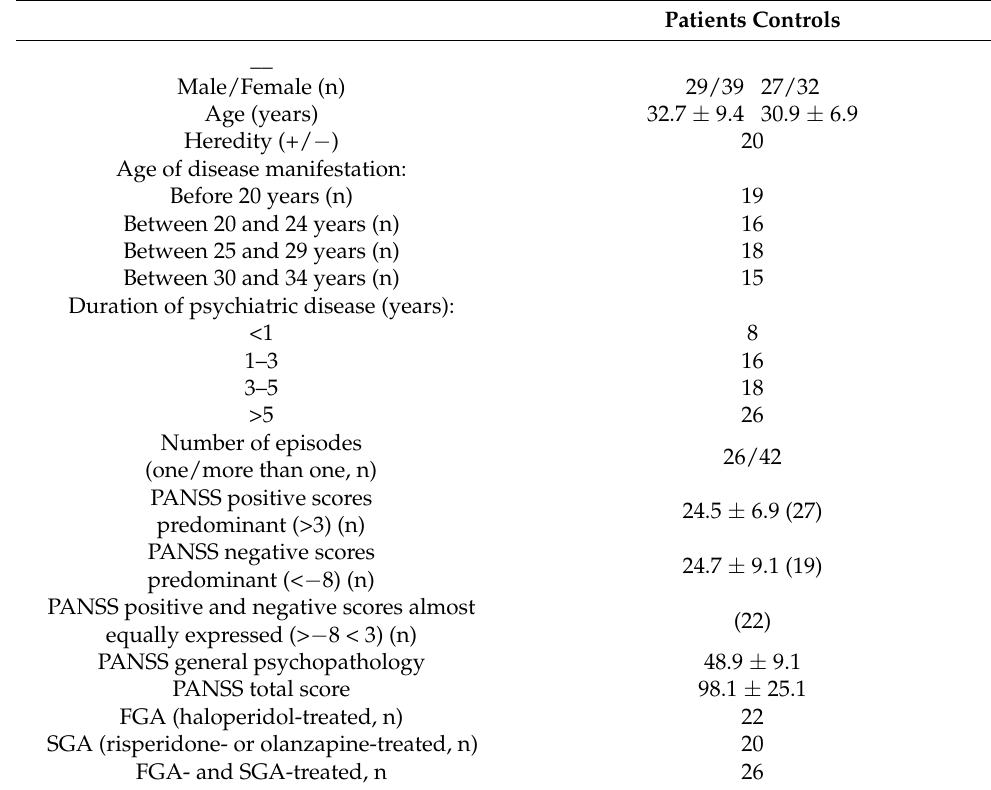
Table 1. Demographic and clinical data of the studied